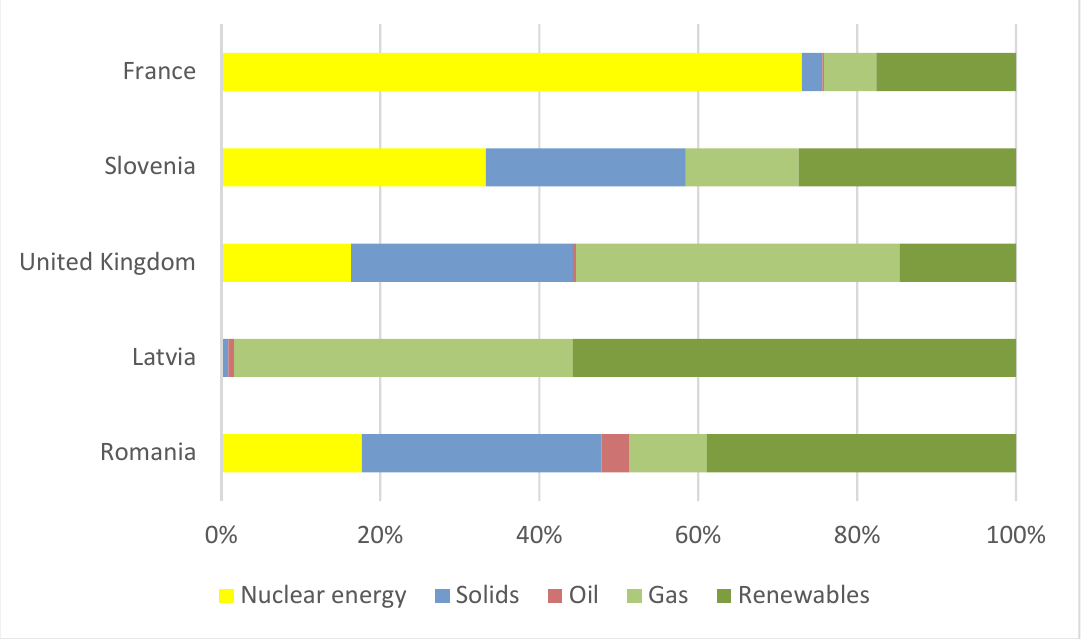
Figure 9. Structure of energy mixes for the fourth cluster. Source (own elaboration).